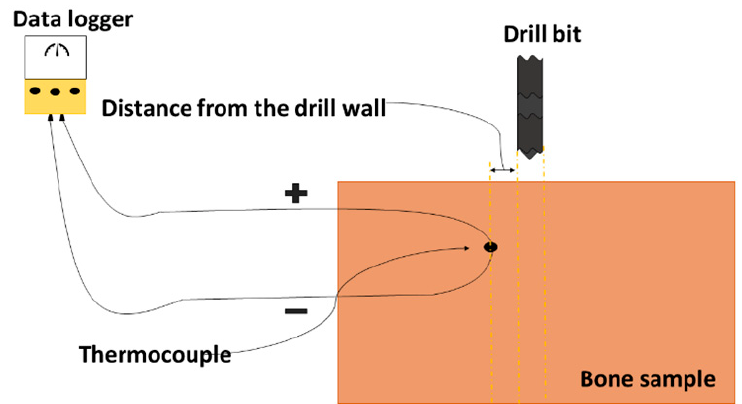
Figure 14. Temperature measurement using a thermocouple [26].